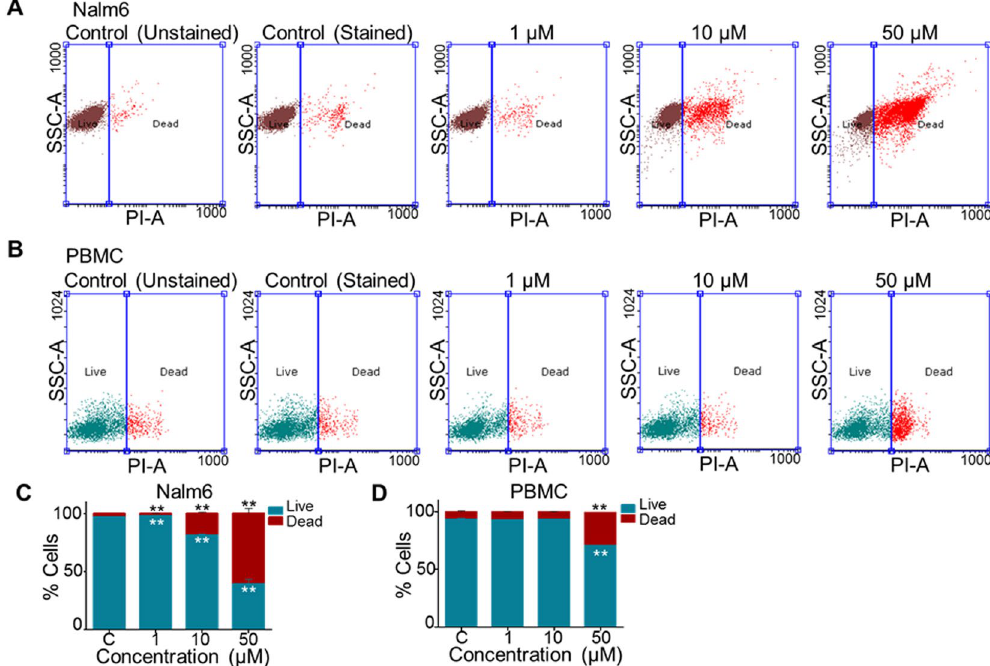
Figure 2. Comparison of cytotoxic effects of 5g in cancer cells and normal cells. ( A , B ) Cytotoxic effect of 5g was compared between Nalm6 cells and PBMCs ( B ). Cells treated with 5g (0, 1, 10 and 50 µ M; 48 h) were subjected to FACS analysis following staining with Propidium Iodide. Dot plots representing effect of different concentration of 5g on Nalm6 cells ( A ) and PBMCs ( B ). ( C , D ) Propidium Iodide positive cells were quantified, plotted as a bar diagram for Nalm6 ( C ) and PBMCs ( D ) respectively (n = 2). Statistical significance was calculated using student t-test and significance was shown if the p-value was equal to or less than 0.05 ( * 0.05, ** 0.005, ***